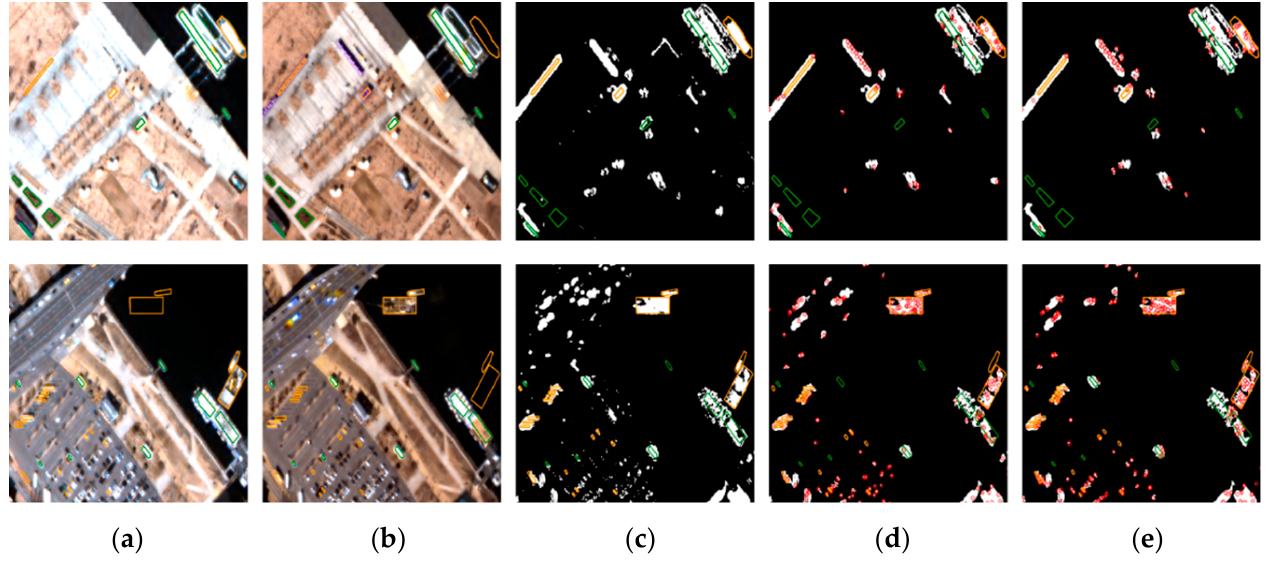
Figure 10. Comparison pixel-based and feature point-based change detection results for Seoul: ( a ) before images, ( b ) after images, ( c ) pixel-based results, and feature-based results using ( d ) SIFT, and ( e ) AKAZE.